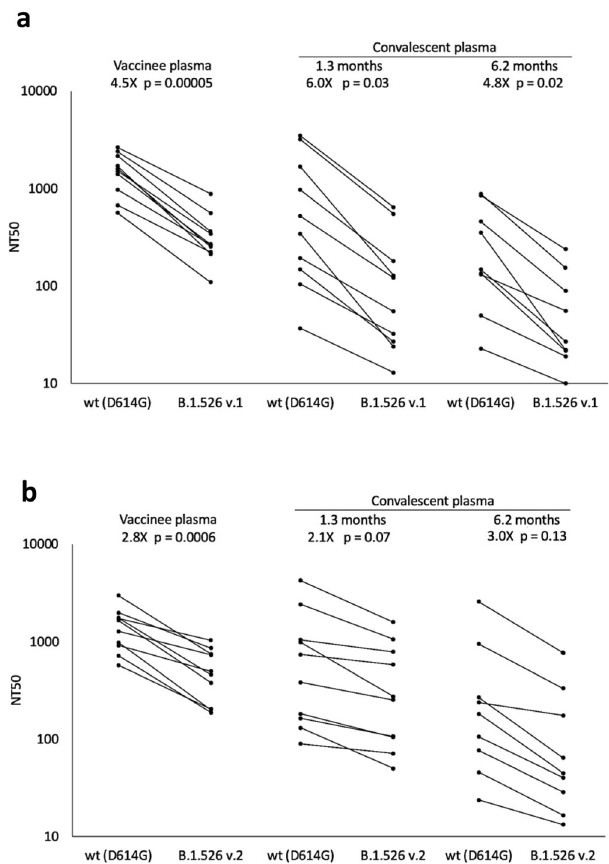
Fig. 5 Plasma neutralizing activity against pseudoviruses with B.1.526 lineage spike mutations. SARS-CoV-2 pseudovirus neutralization assays were used to determine neutralization titer (NT50) for COVID-19 vaccinee ( n = 10) and convalescent plasma at 1.3 months ( n = 10) and 6.2 months ( n = 9) after infection. a Pseudovirus with spike mutations L5F, T95I, D253G, E484K, D614G (B.1.526 v.1), and A701V. b Pseudovirus with spike mutations L5F, T95I, D253G, S477N, D614G, and Q957R (B.1.526 v.2). Statistical signi fi cance was determined using paired two-tailed t -tests. Fold differences of means are